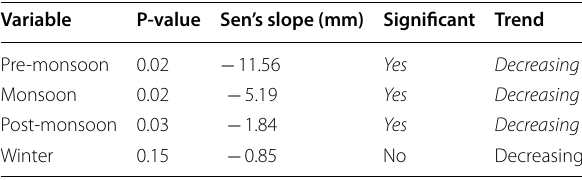
Table 4 Mann–Kendall test and Sen’s slope statistics of seasonal mean rainfall Variable